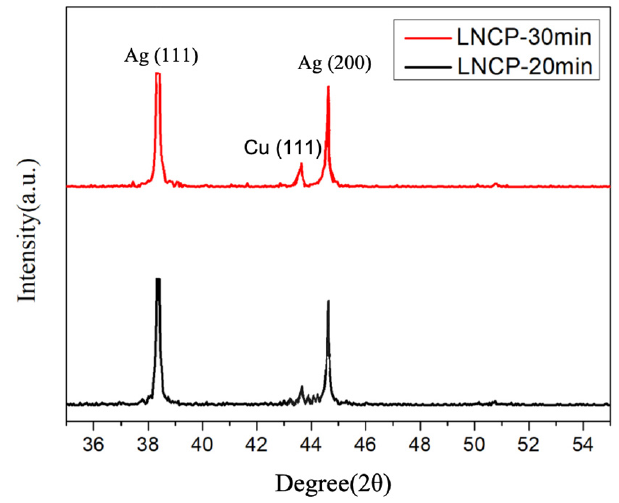
Figure 5. SRXRD patterns of LNCP subjected to isothermal heating at 160 °C for 20 or 30 min. The organic residues in the LNCP sintered structure were examined by FTIR. Figure 6a shows the FTIR spectra of PVP and the six carbon-chain-carboxylate-protected Ag NPs before sintering. The large band observed between 3750 cm − 1 and 3000 cm − 1 was linked to O-H stretching. The major PVP peaks were 1650 cm − 1 , 1428 cm − 1 , and 1288 cm − 1 . As also indicated in Figure 6a, ν as CH 2 , ν s CH 2 , ν as CO 2 − , and ν s CO 2 − stretching peaks were detected [22]. After being subjected to thermal compression at 160 °C for 30 min, there was almost nothing left of the sintered LNCP (red curve), as shown in Figure 6b. Meanwhile, very tiny peaks were observed on the black curve (sintered 6 C-LNCP with ethyl cellulose), which were attributed to C-H and CO 2 − stretching.